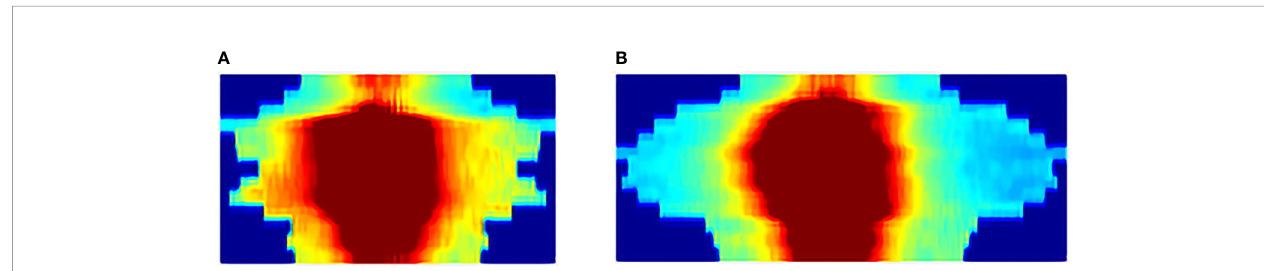
FIGURE 4 | Example 2D-RSDM of a patient with (A) pre- KN and (B) post- KN